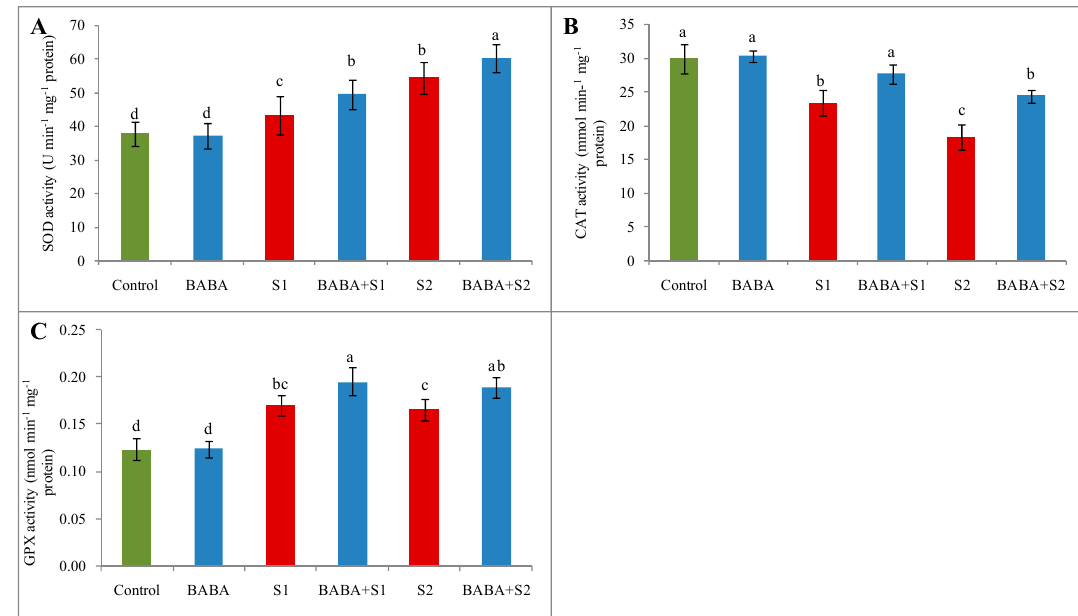
Figure 5. Effect of BABA on activity of superoxide dismutase (SOD) ( A ), catalase (CAT) ( B ), and glutathione peroxidase (GPX) ( C ) of rapeseed ( Brassica napus L.) seedlings exposed to different concentrations of salt stress. Average from three replications (n = 3) was used to determine mean ( ± SD) for each treatment. Letters with different values varied significantly at p ≤ 0.05 according to Fisher’s LSD test. Here, BABA, S1 and S2 indicate 150 μ M β -aminobutyric acid, 100 mM NaCl and 150 mM NaCl, respectively.